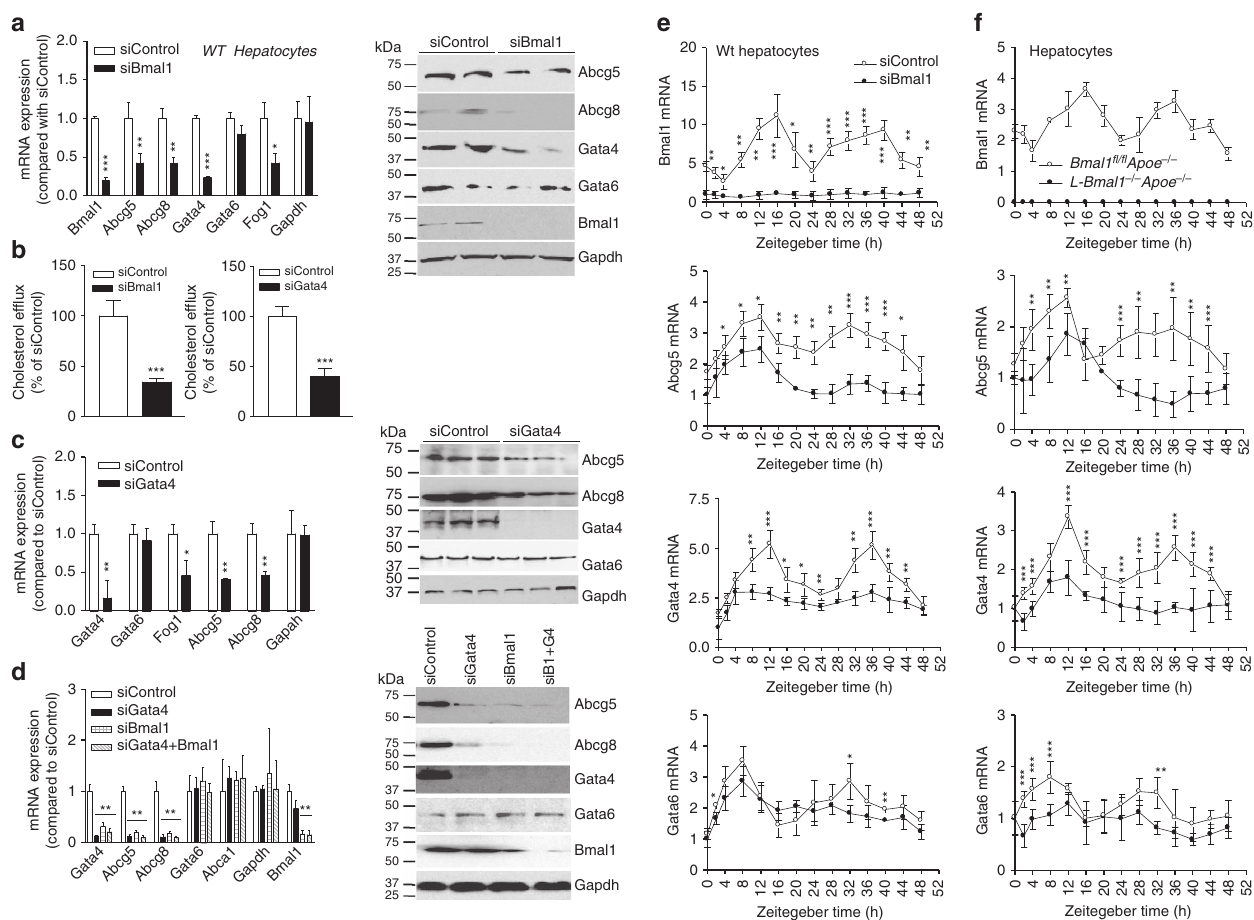
Figure 6 | Bmal1 regulates cholesterol excretion to bile by modulating Gata4 expression. ( a ) Wild-type primary hepatocytes were transfected in triplicate with siControl or siBmal1 and different mRNA levels were measured after 48h (left). In a separate study, hepatocytes were transfected and used to detect protein levels (right). ( b ) Cholesterol efflux to bile acid acceptors was measured in wild-type hepatocytes transfected with siControl or siBmal1 (left). Also, primary hepatocytes were transfected with siControl or siGata4 (right). After 48h, cells were labelled with 3 H-cholesterol, washed and incubated with media containing 10mM TUDC for 60min. Radioactivity was determined by scintillation counting. ( c ) Wild-type hepatocytes were transfected with siGata4 or siControl and mRNA (left) and protein (right) levels of different indicated genes were quantified. ( d ) Primary hepatocytes were transfected with siControl, siGata4, siBmal1 or siBmal1 þ siGata4. After 48h, mRNA (left) and protein (right) levels of indicated proteins were quantified. ( e ) Wild-type primary hepatocytes were transfected with siControl or siBmal1. After 48h, cells were subjected to 2h serum shock. At indicated times; mRNA levels of different genes were measured and corrected with 18S rRNA. The values in one well were normalized to 1. Other values represent fold-change compared with 0h. ( f ) Hepatocytes from L-Bmal1 (cid:2) / (cid:2) Apoe (cid:2) / (cid:2) and L-Bmal1 fl/fl Apoe (cid:2) / (cid:2) mice (3 months, male) were cultured and subjected to serum shock and changes in mRNA levels of indicated genes were quantified at indicated times. Data in a – d were tested using the unpaired Student’s t -test. Data in e and f were examined by two-way ANOVA. Values are mean ± s.d. * P o 0.05, ** P o 0.01 and *** P o 0.001. Error bars represent 10-fold (Fig. 8a). GATA4 overexpression had no effect on Gata6 ablated mice (Fig. 7d,f). Bmal1 interacted with the Gata4 , but and Gapdh mRNA and protein levels, but increased Abcg5, not with Gata6 , promoter and this binding was not seen in Abcg8, Fxr and Shp mRNA and protein while decreasing MTP L-Bmal1 (cid:2) / (cid:2) Apoe (cid:2) / (cid:2) livers. Binding of Bmal1 to Gata4 pro- expression when compared with mice transduced with Ad-GFP moter was higher at 16:00 h compared with 4:00 h. Gata4 binding (Fig. 8a). Further, Gata4 overexpression decreased MTP activity to the Abcg5 promoter was high in Bmal1 fl/fl Apoe (cid:2) / (cid:2) mice at (Fig. 8b), and plasma triglyceride and cholesterol in non-HDL 16:00h but was significantly attenuated in L-Bmal1 (cid:2) / (cid:2) Apoe (cid:2) / (cid:2) lipoproteins (Fig. 8c). Hepatic cholesterol was unaffected but mice. These data suggest that Bmal1 interacts with Gata4 triglyceride was increased (Fig. 8d). In addition, bile and fecal promoter at the onset of nighttime to increase expression cholesterol levels were increased after the overexpression of resulting in enhanced binding of Gata4 to the Abcg5 promoter. GATA4 (Supplementary Fig. 18). Mice overexpressing GATA4 accumulated more cholesterol in the bile compared with mice overexpressing GFP after intravenous injection of 3 H-cholesterol (Fig. 8e). Further, cholesterol efflux from J774 macrophages during RCT to the liver, feces and bile was higher in GATA4 expressing mice compared with GFP expressing mice (Fig. 8f). expression by Bmal1. To test this further, L-Bmal1 (cid:2) / (cid:2) Apoe (cid:2) / (cid:2) GATA4 expression reduced lesion areas in the aortic arches and lipid staining in the abdominal aortas by B 60–75% (Fig. 8g,h).